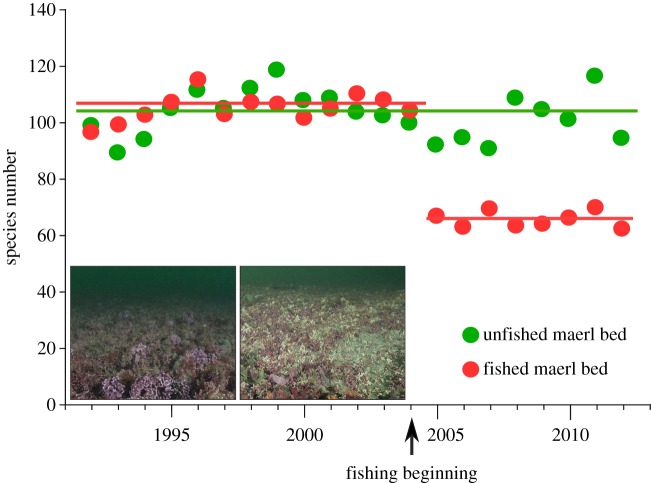
Invertebrate species richness in two maerl beds exposed to different fishing practices: no fishing (green dots); fishing (red dots), beginning in 2004 (arrow). Each point represents the mean number of species identified in three replicate sediment samples (each 0.1 m−2) collected in autumn with a Smith–McIntyre grab. The lines show the average of all points over the indicated time. Insets show images of the maerl bed surface, acquired from unfished (left) and fished (right) regions.